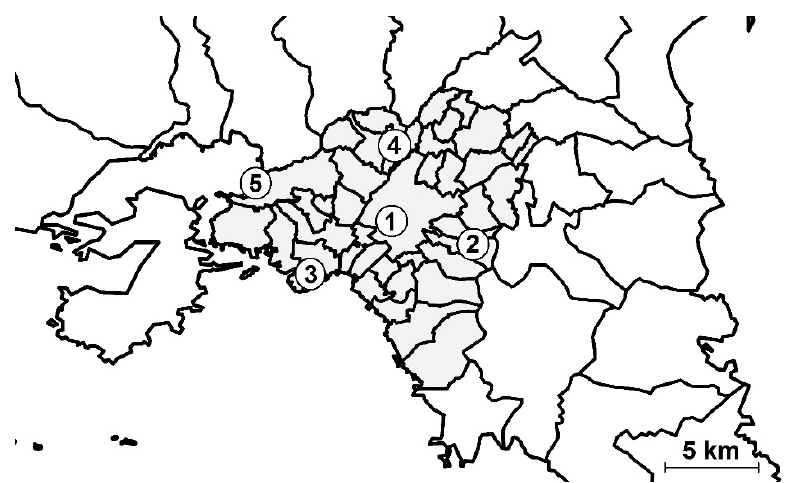
Figure 1. Air quality measurement stations in the metropolitan Athens area; 1: central Athens (urban), 2: AgiaParaskevi (suburban), 3: Pireaus (urban), 4: Lykovrisi (suburban), 5: Eleusis/Aspropyrgos (industrial); for each woman, the nine-month average of air pollutants’ levels from the closest station to her residence was taken into consideration.